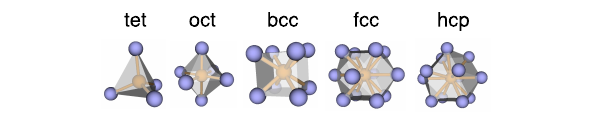
FIGURE 1 | Basic structural motifs that frequently recur in various materials databases (from left to right): tetrahedron (tet), octahedron (oct) as well as body-centered cubic (bcc), face-centered cubic (fcc), and hexagonal close packed (hcp) motifs. The central atom and bonds are shown in orange, whereas the coordinating atoms are displayed in